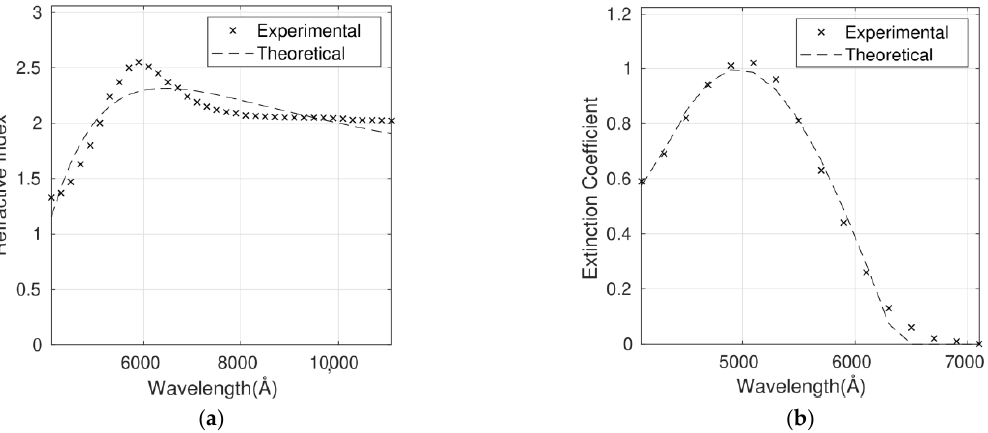
Figure 7. Refractive index ( a ) and extinction coefficient ( b ) fits to Cauchy´s equation for the P3HT/G (1 wt %) nanocomposite. Experimental data are adapted from Ref. [9] with permission from the American Institute of Physics, 2012.